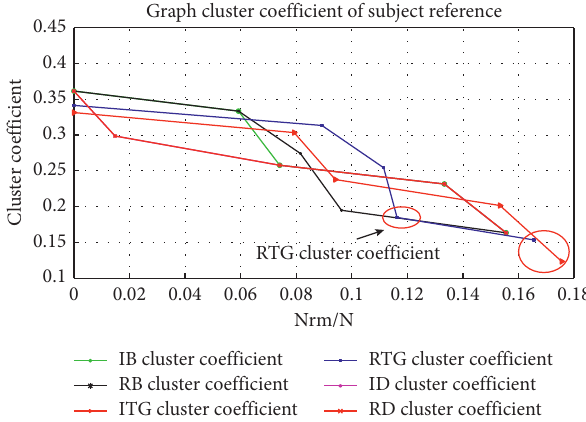
Figure 12: C G �( V,E ) result of subject reference.